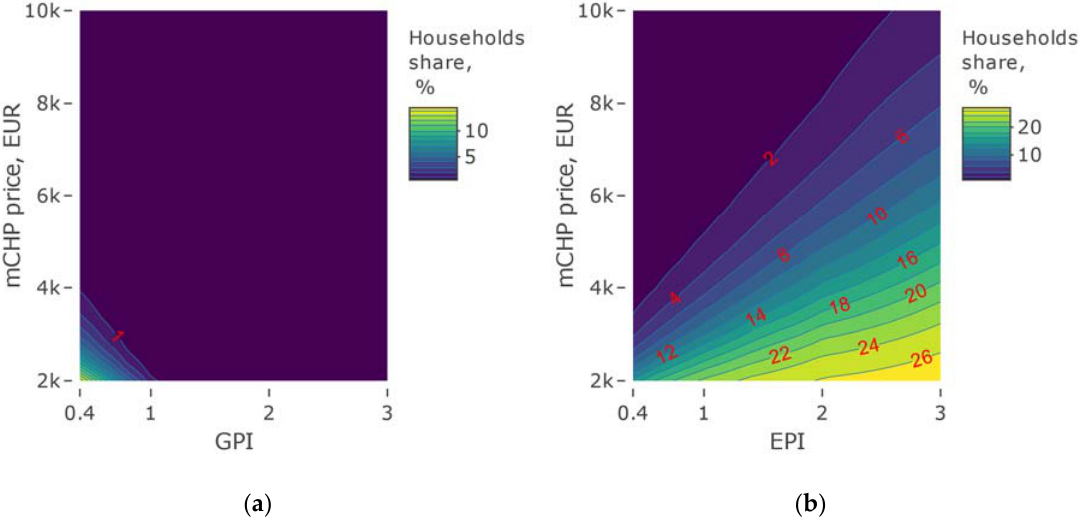
Figure 11 . Household share for: ( a ) EPI = 0.4 and different GPI; ( b ) GPI = 0.4 and different EPI.